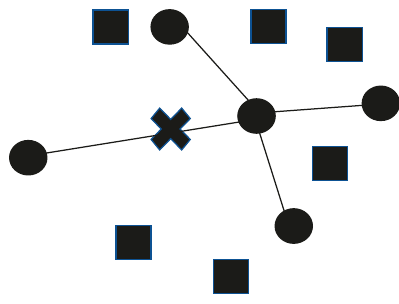
Figure 1: Schematic diagram of SMOTE.